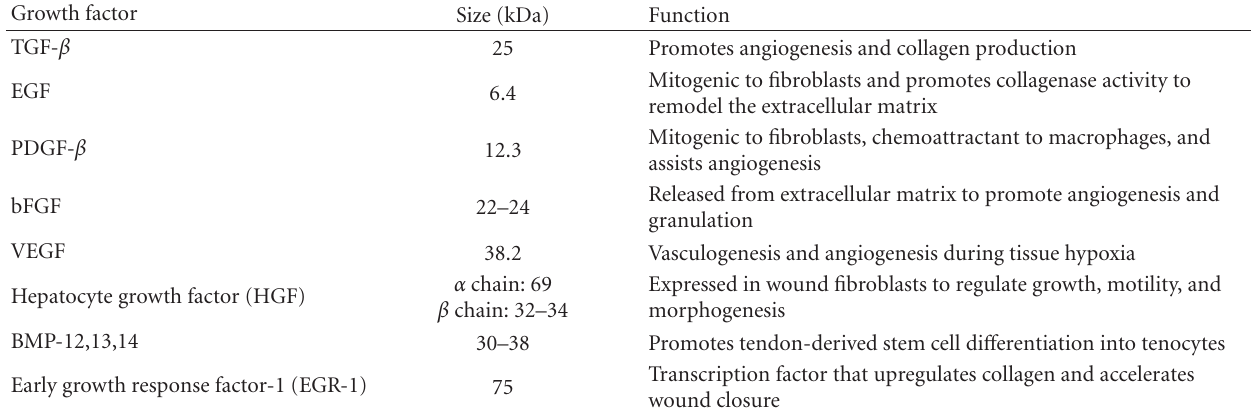
Table 4: Summary of growth factors necessary in tendon